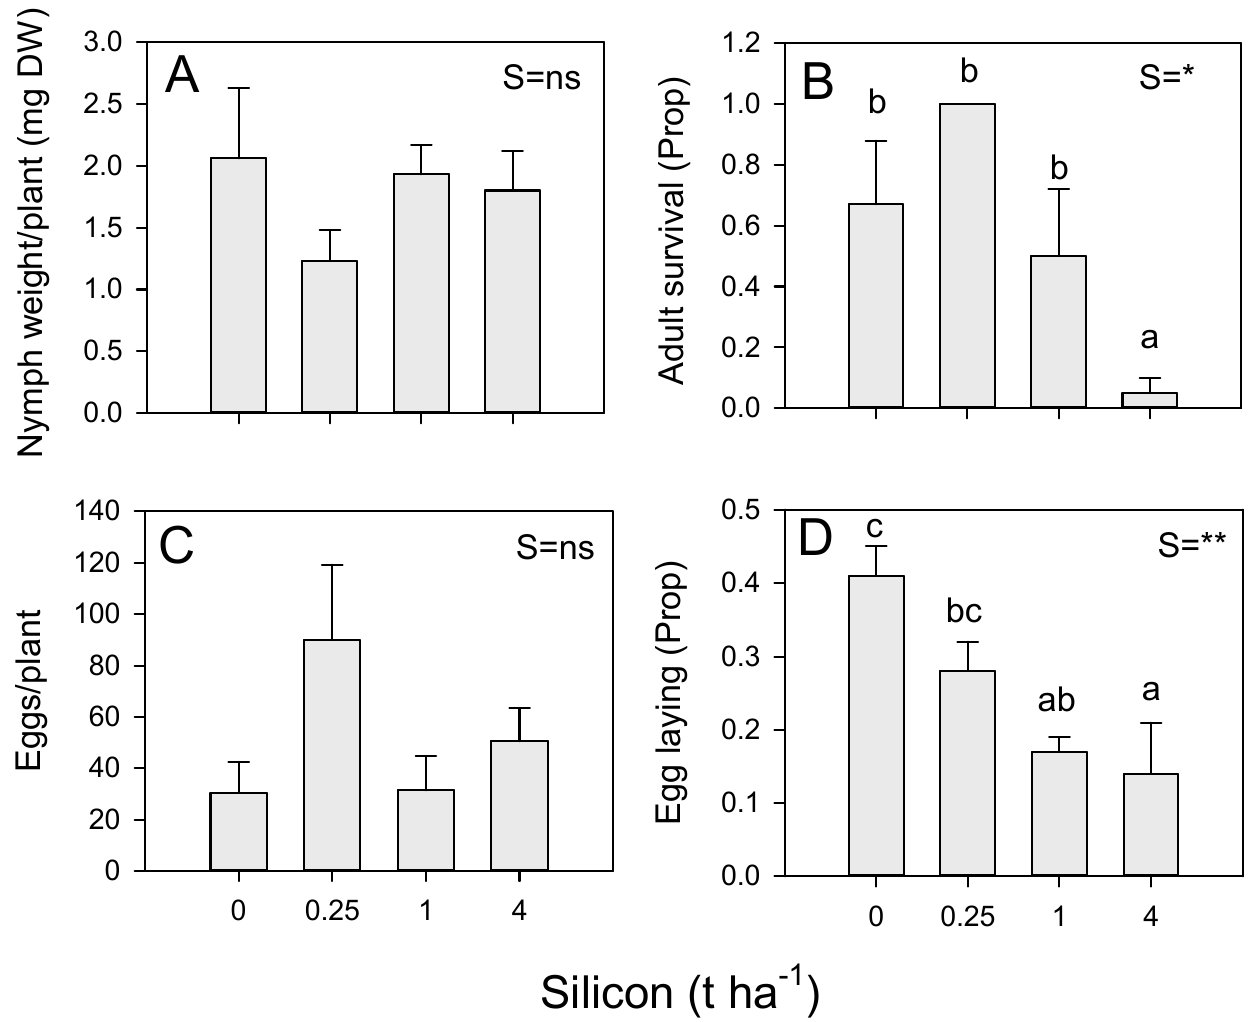
Figure 4. Effects of soil silicon on BPH ( A ) nymph weights, ( B ) adult survival and ( C ) egg laying during no-choice experiments conducted using rice variety IR50404 in Vietnam, and on BPH ( D ) egg laying during a corresponding choice experiment. Soil was amended with 0, 0.25, 1 and 4 t ha − 1 equivalents of silicon. Standard errors are indicated (sample size = 6). Summary statistics for univariate general linear models are indicated as S = silicon, ns = p > 0.05, * = p ≤ 0.05 and ** = p ≤ 0.01; lowercase letters indicate homogenous silicon groups. See also Tables S7 and S8.